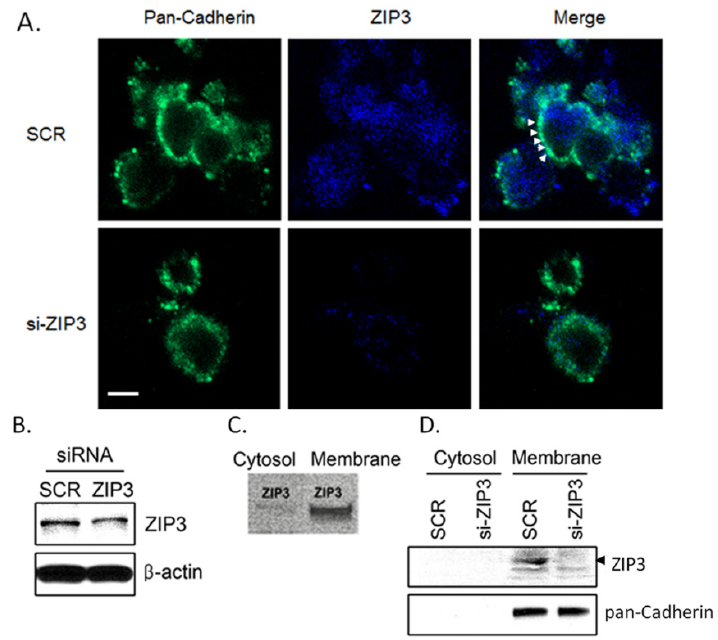
Figure 1. Zip3 protein expressions in rat β -cells. ( A ) Zip3 proteins (see arrowheads) are evident in the cell membrane at × 400 magnification. Magnification ruler indicates 5 μ m. ( B ) Western blot assay results on the whole cells harvested from control (scrambled or SCR) β -cells and the β -cells with siRNA-mediated Zip3 knockdown. ( C ) When fractionated into cytoplasm and plasma membrane portions, Zip3 protein is expressed in the plasma membrane more than the cytoplasm portion. ( D ) Pan-Cadherin protein clearly reveals that Zip3 resides in the membrane. ZIP3 with arrowhead approximates the position of Molecular Weight 34.